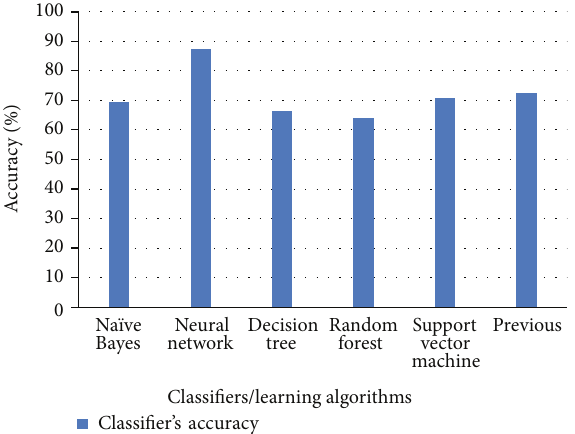
Figure 6: Comparison of each classifier’s classification accuracy using dataset 1.